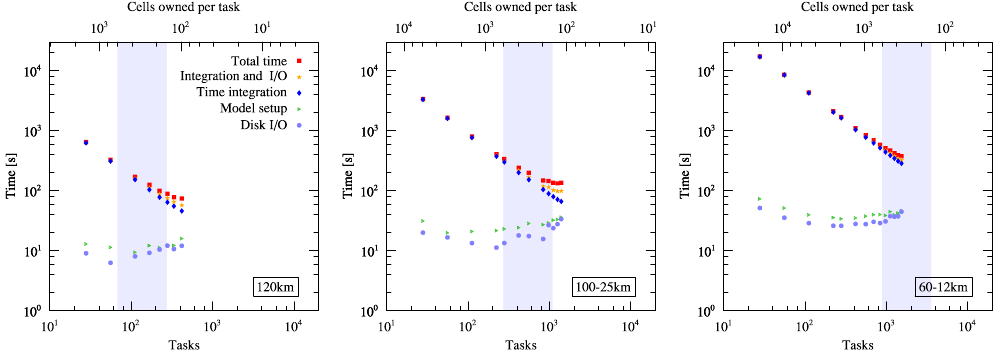
Figure 7. Required time for a 24h integration (s) split into time integration, model set-up and disk I/O for the three test cases on Jtest-full. Also displayed are the total time and a combination of time integration and disk I/O to reflect the parallel performance of MPAS-A for longer model runs, for which the initial set-up costs are